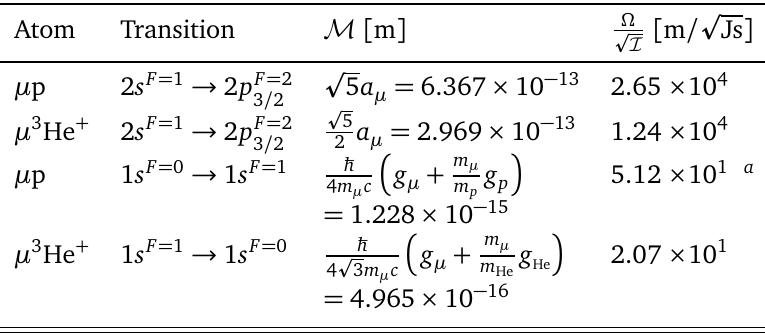
Table 2: Values of